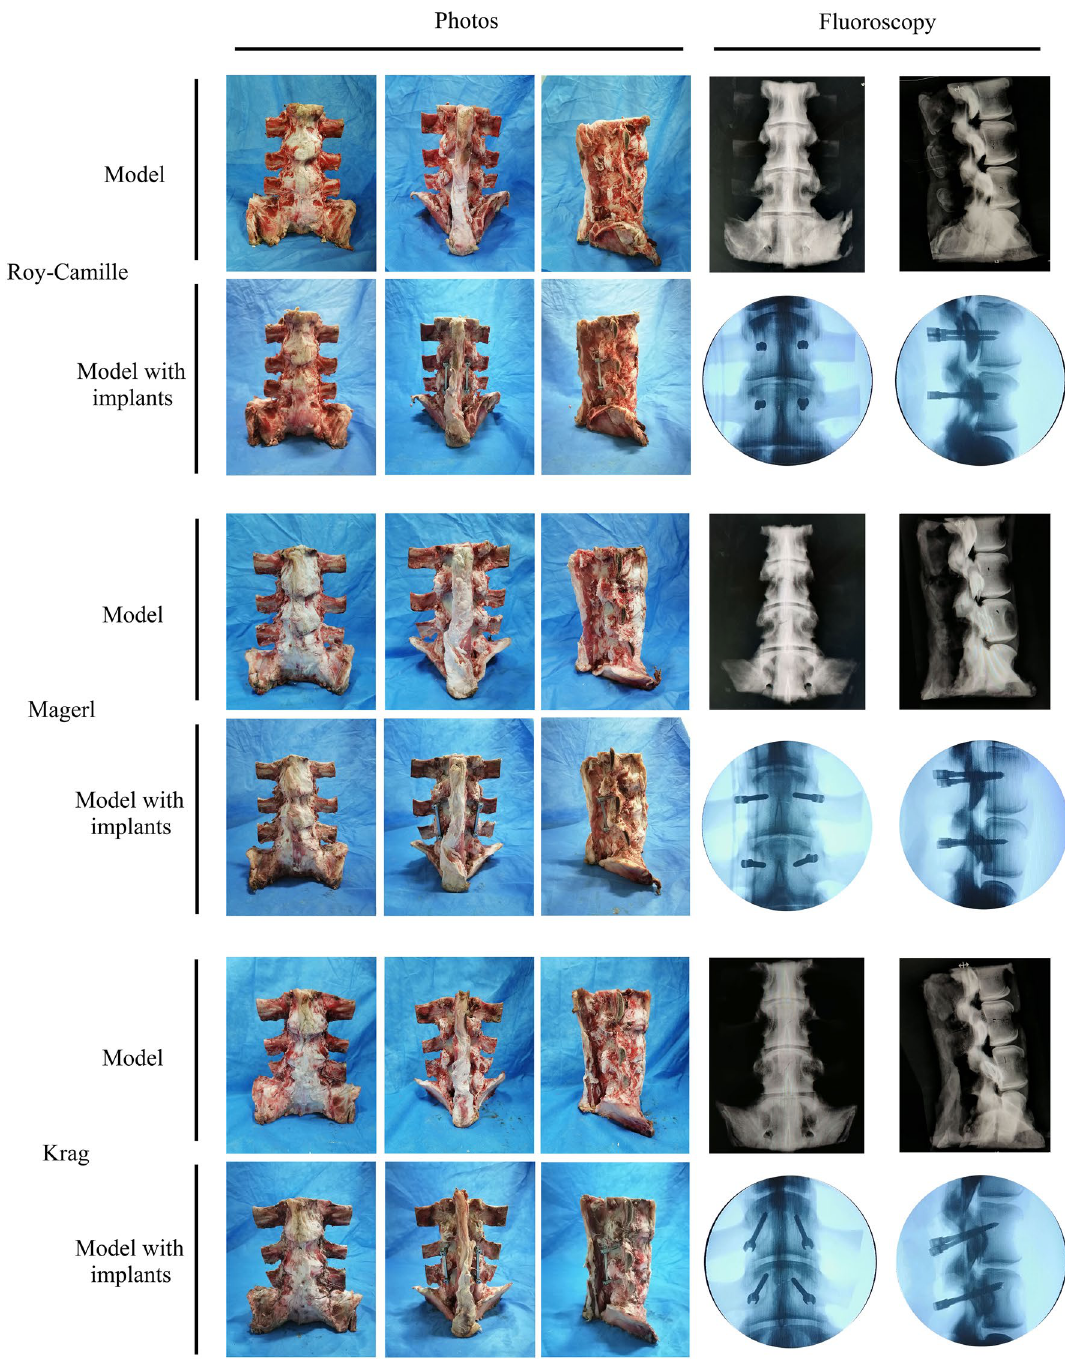
Figure 10. The processing of the